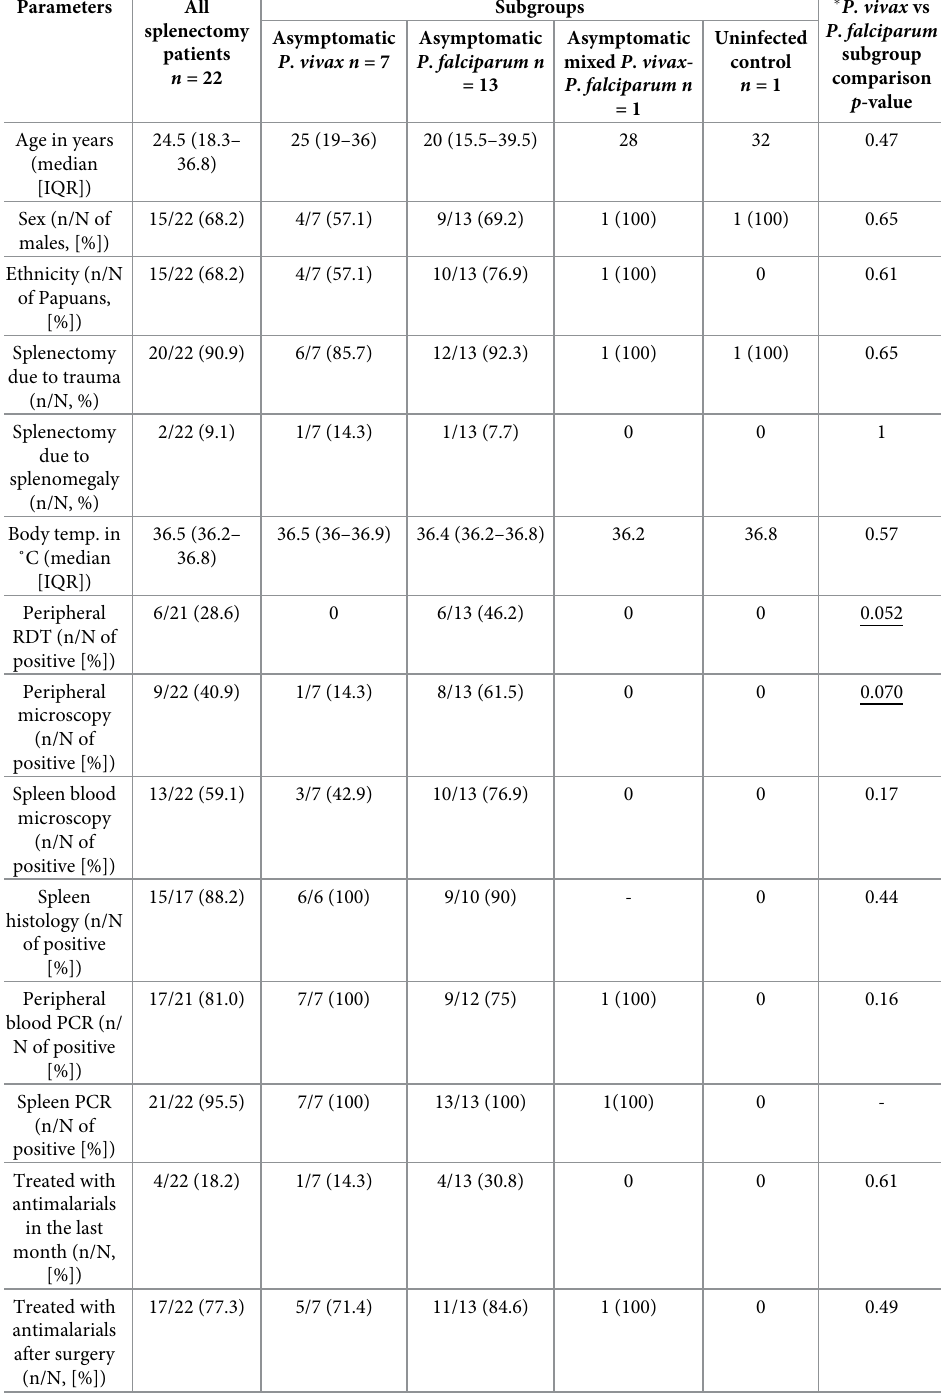
Table 2. Baseline characteristics of n = 22 splenectomy patients in Papua,